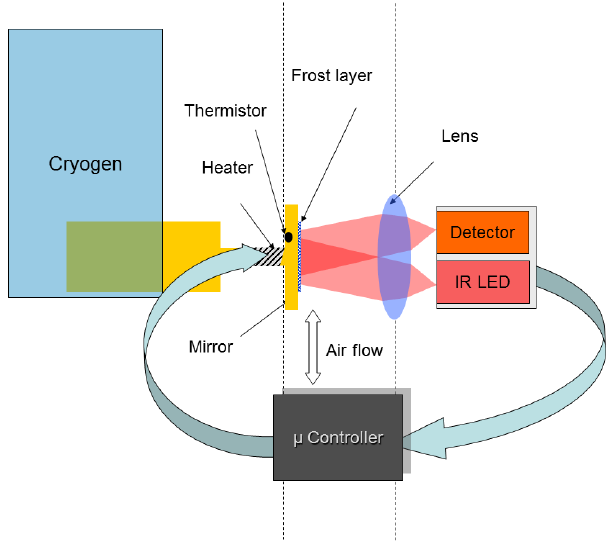
Figure A3. Schematic of the CFH sonde. The vertical dashed lines indicate the inlet and outlet tubes. The airflow inside the tubes is downward during balloon ascent and upward during descent. Only the lens and the mirror are exposed to the airflow inside the tube. The microprocessor controller regulates the mirror tempera- ture such that the bulk reflectivity of the frost-covered mirror re- mains constant (Vömel et al.,